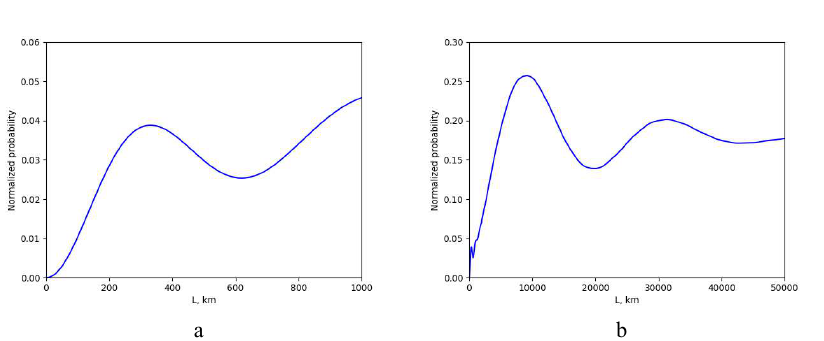
Figure 2. Normalized probability of the neutrino oscillation process with the detection by a nucleon and electron production on spatial scales a) 1000 km and b) 50000